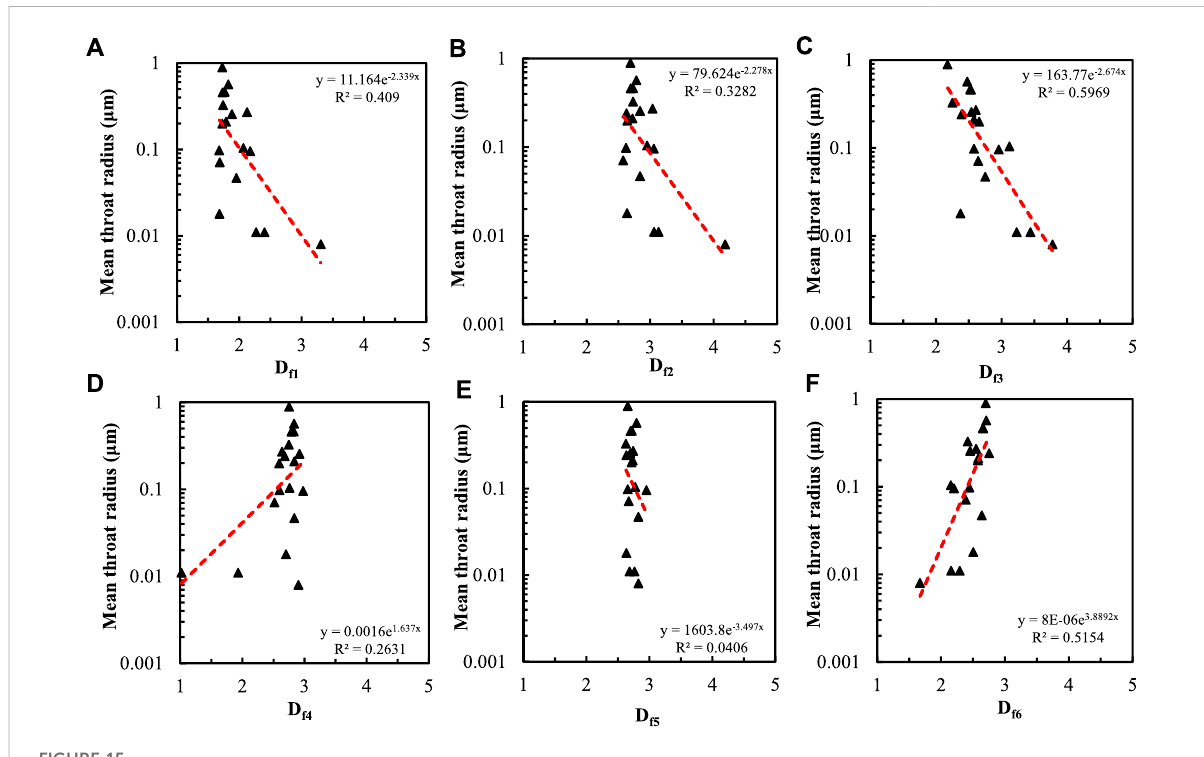
FIGURE 15 Relationship between average throat radius and fractal dimension calculated by six